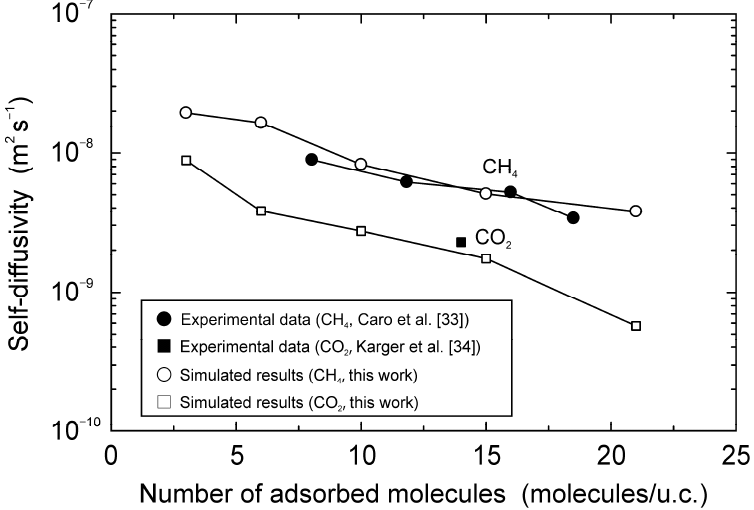
Figure 8. Influences of the number of adsorbed molecules on the self-diffusivities of CH 4 and CO 2 at 298 K.